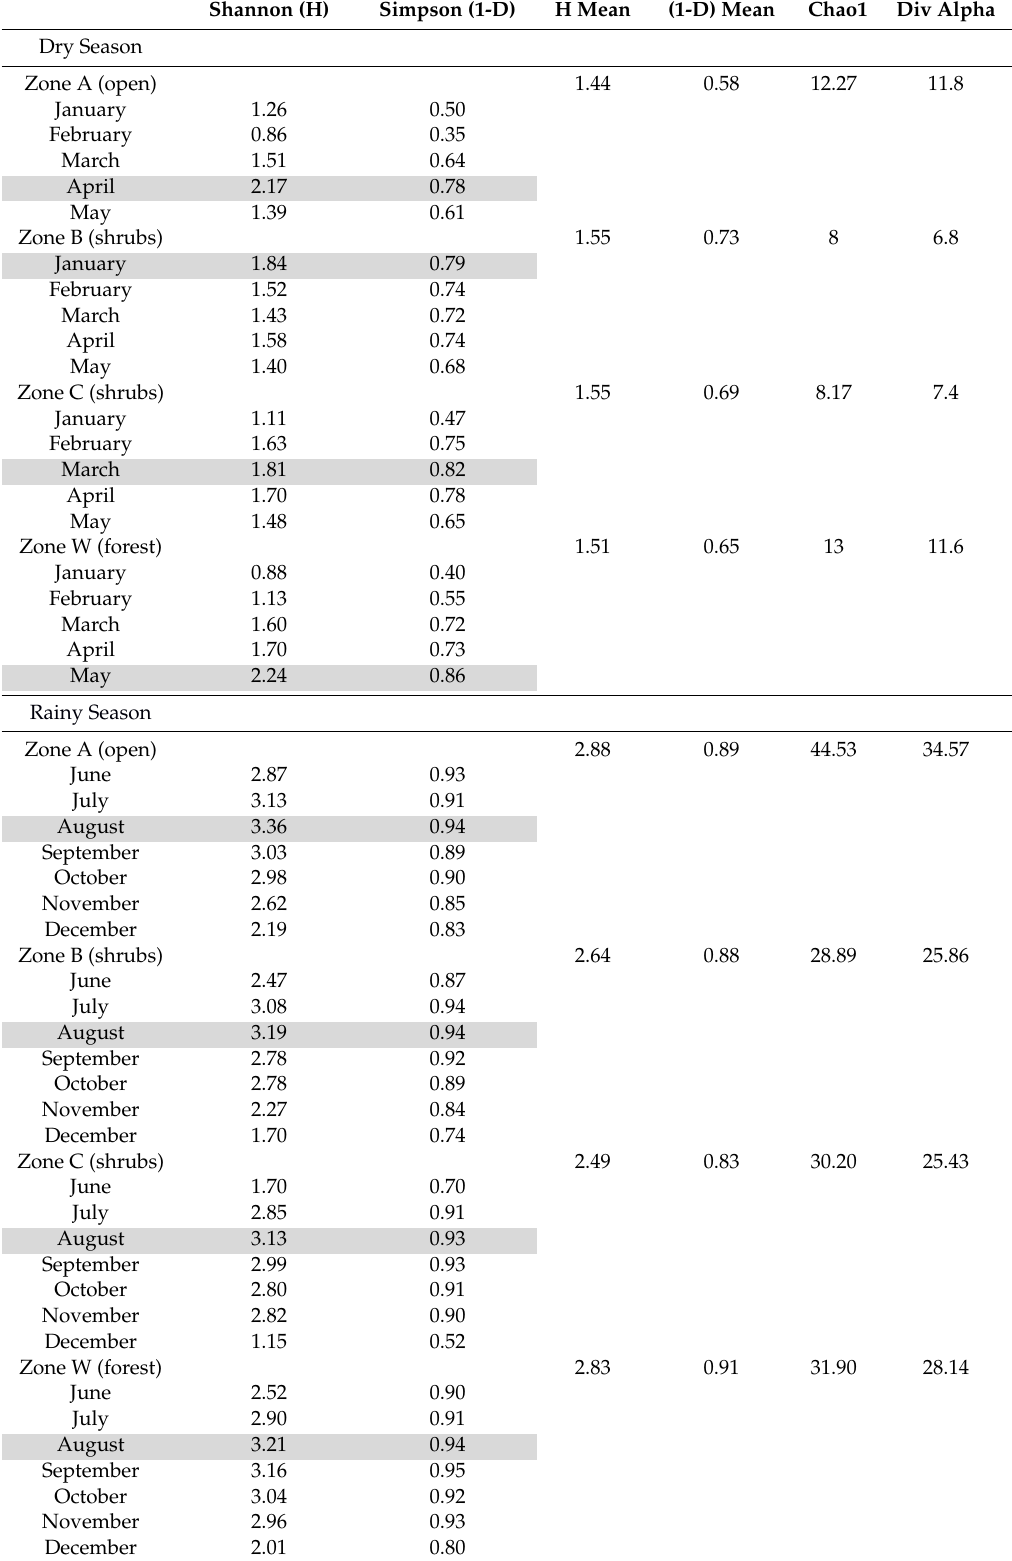
Table 1. Various diversity indices by months (first set is the dry season, second set is the rain season) and by sites (A, B, C and W). Highlighted in gray are the highest values per season for each site. Shannon (H) Simpson (1-D) H Mean (1-D) Mean Chao1 Div